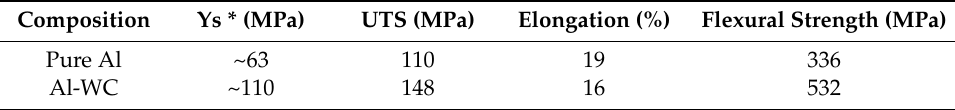
Table 2. Mechanical properties of non-reinforced Al and of Al-1 vol.% WC composite. Composition